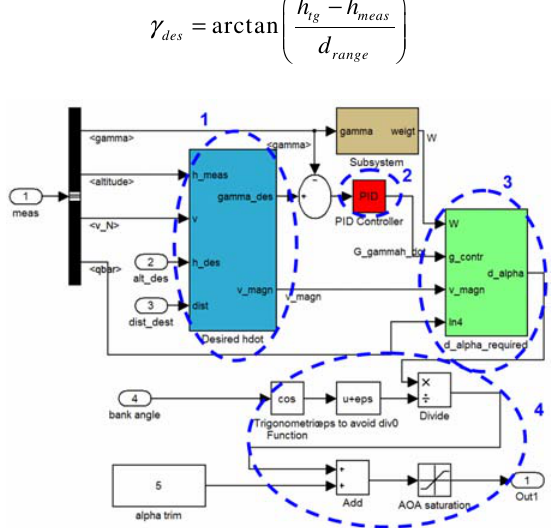
Fig 4. Vertical guidance algorithm designed in Simulink environment. Its main components: 1 – desired flight path angle computation, 2 – PID for flight path angle rate